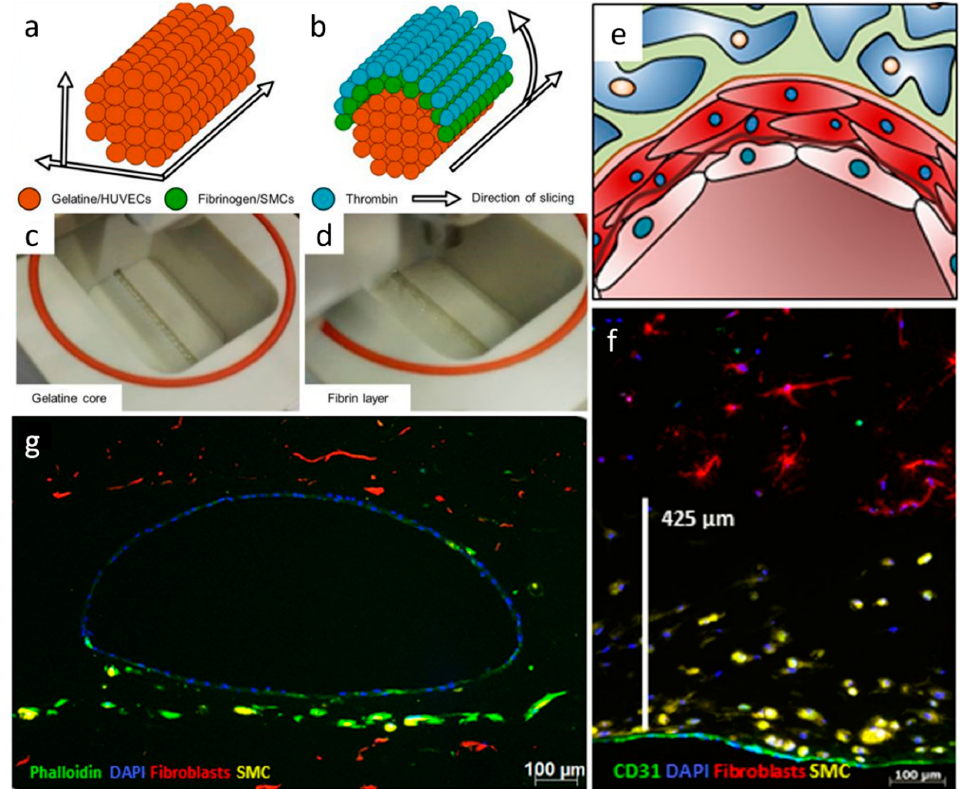
Figure 9. Printing procedure to manufacture vascular channels in custom-made bioreactors. ( a ) The gelatine core is deposited by following a printing pattern, which is created by slicing the channels horizontally and calculating the droplets in a grid for each longitudinal section. ( b ) For the surrounding fibrin layer, the deposition pattern is calculated by slicing the channel lengthwise and defining droplet positions in angular steps around the channel outline of each cross section. ( c ) To deposit the gelatin core, a single printer head is used at 37 °C. ( d ) Two printer heads are used, filled with fibrinogen and SMCs alternatingly, as well as thrombin as a crosslinker. ( e ) Schematic cross section of the channel in close-up shows a single layer of ECs and an additional SMC layer. ( f ) Combination of SMC layer and the EC layer showing the distribution of SMCs close to the intact channel as a cross section after seven days of flow (CD31 in green, pre-labeled fibroblasts in red, pre-labeled SMCs in yellow, DAPI in blue, 20 × ). ( g ) A representative fluorescence microscopy image in cross-section highlights the whole architecture of a multi-layered vessel model after four days of dynamic cultivation; EC are homogenously distributed in the inner part of the lumen, surrounded by fibroblasts and SMCs (phalloidin in green, pre-labeled fibroblasts in red, pre-labeled SMCs in yellow, DAPI in blue, 5×). ( a – g ) Figure adapted from Schöneberg et al., 2018. Engineering biofunctional in vitro vessel models using a multilayer bioprinting technique. Scientific Reports, Copyright (2018) [21].